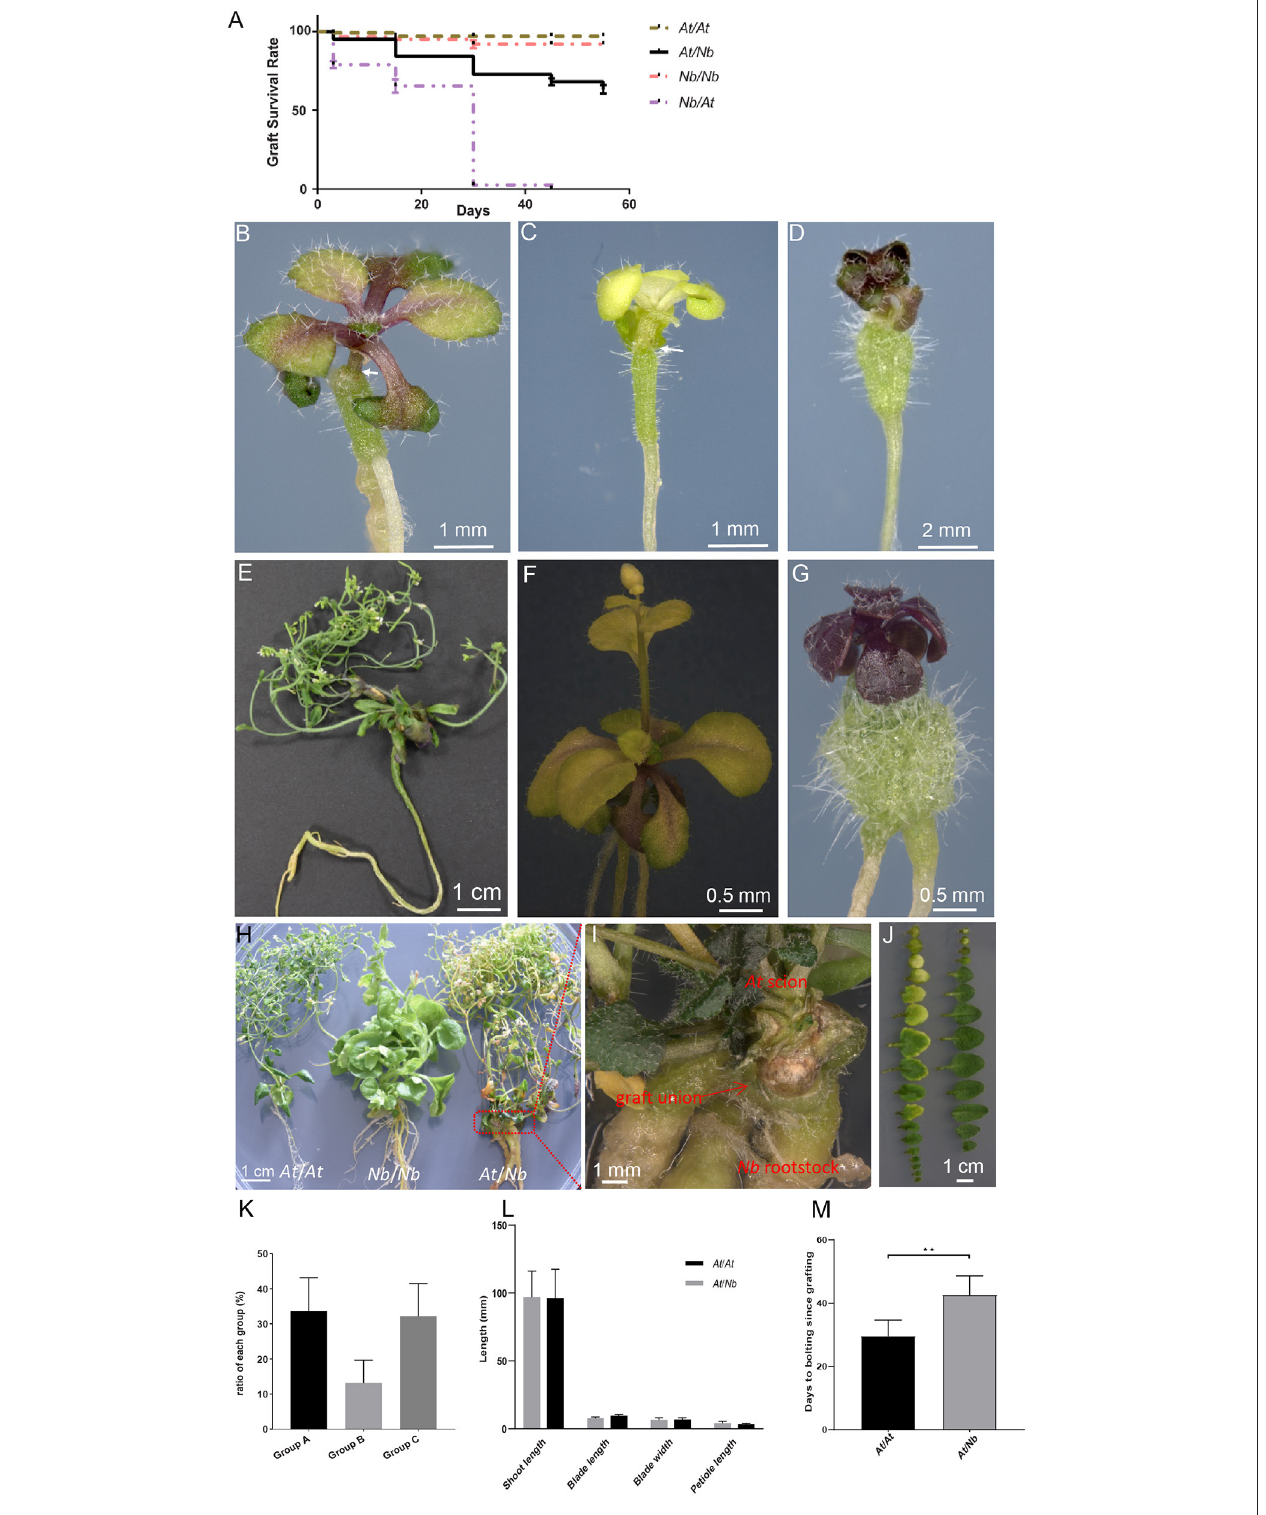
FIGURE 1 | Three types of At / Nb heterografts grown under aseptic conditions. (A) The survival rate of self-grafts and heterografts. (B) A representative plant of group A grafts that show mild stress at 30 DAG. (C) A representative plant of group B grafts with a chlorotic phenotype at 30 DAG. (D) A representative plant of group C grafts, showing highly retarded growth or quiescent state at 30 DAG. (E) A 135 DAG graft from group A. (F) A 45 DAG graft from group B. (G) A 45 DAG graft from